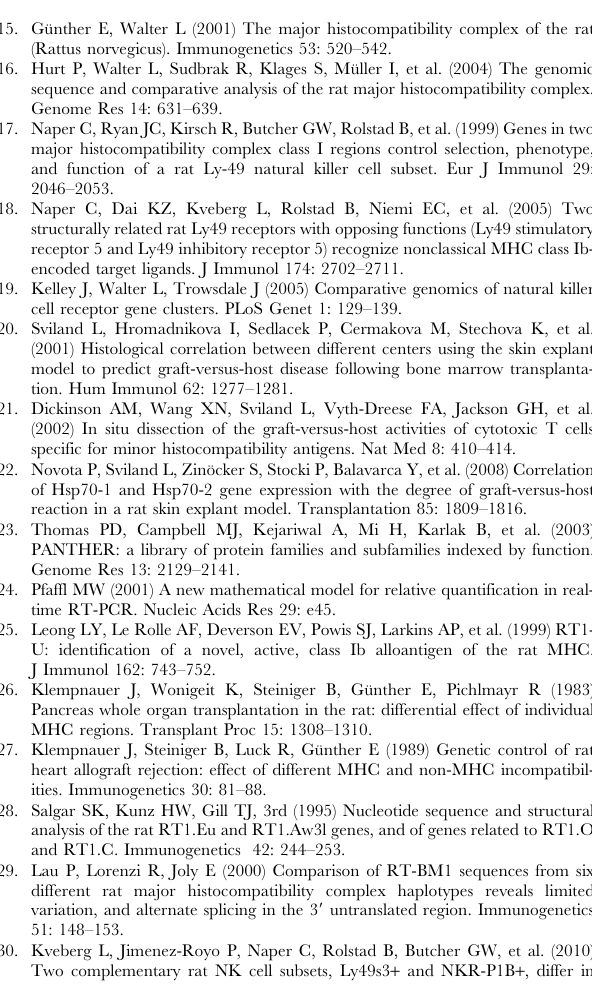
Table S3 Regulated non-MHC non-NKC genes. The expression profiling results of non-MHC non-NKC genes are given for those genes that were both significantly (p , 0.05) and strongly (log2-fold change $ 1 or #2 1; i.e. fold change $ 2 or # 0.5) regulated. The log2-fold changes and the fold changes in